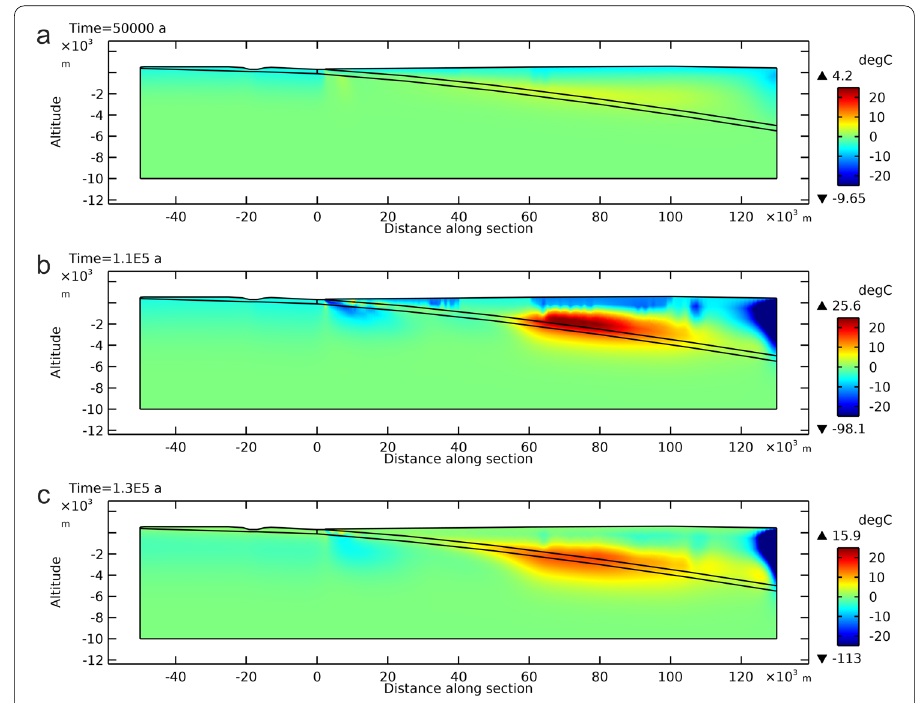
Fig. 17 Temperature difference between the paleo-temperature condition and the constant surface-temperature condition in the high Malm permeability scenario (i.e. difference between model runs E and G introduced in Fig. 3): a 80 ka ago (time